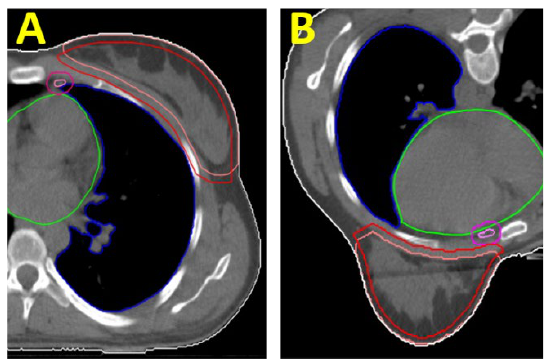
Figure 2. CT sections of a patient with left-sided breast cancer: ( A ) in the supine and ( B ) in the prone positions. Contours marked are the CTV “B” (light red), the PTV “B” (red), the CTV “PSR” (pink), and the PTV “PSR” (purple). In addition, the OAR “heart” (green) and OAR “left lung” (blue) are depicted.